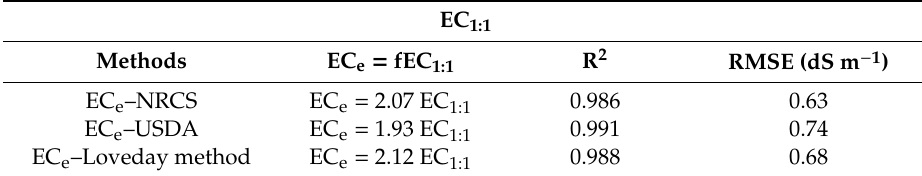
Table 6. Regression equations describing the relation between saturated paste extracts EC e and EC 1:1 determined by three di ff erent methods with the coe ffi cients of determination (R 2 ) and root mean square errors (RMSE) for all soil examined.